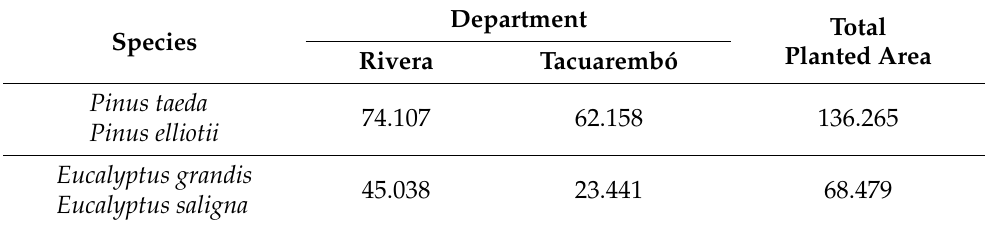
Table 1. Plantation area (ha) according to the species planted in the region [26].